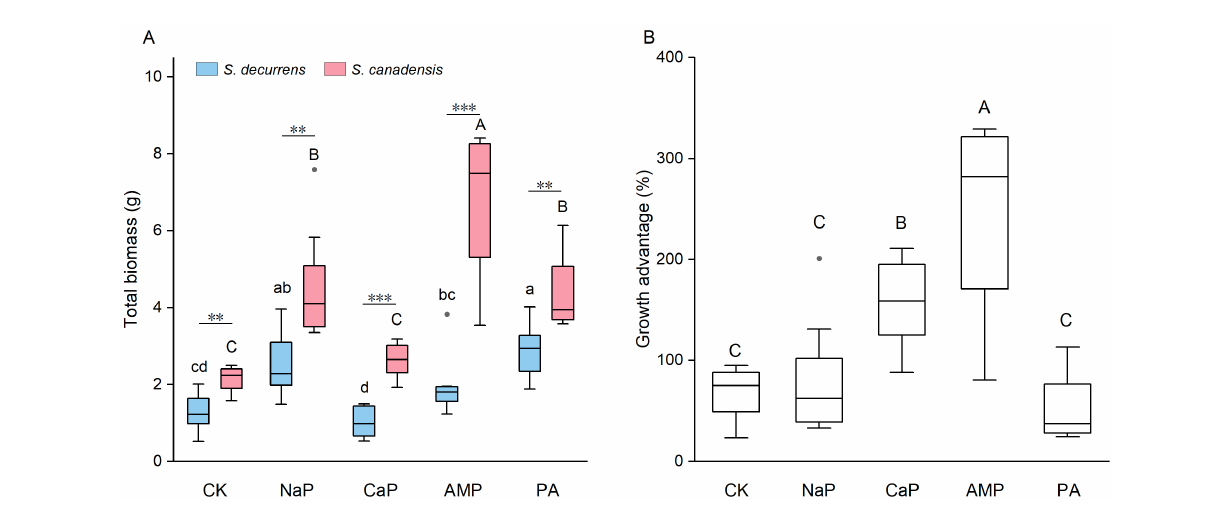
FIGURE 1 (A) Total biomass of S. decurrens and S. canadensis grown under five P treatments. CK: no P addition; NaP: sodium dihydrogen phosphate; CaP: hydroxyapatite; AMP: adenosine monophosphate; PA: myo-inositol hexakisphosphate. The line in the box represents the median value, box boundaries indicate the value in the 25–75th percentile range, whiskers indicate the 95% confidence intervals. The different lower-case letters among S. decurrens and different upper-case letters among S. canadensis denote significant differences at p < 0.05. The asterisks denote difference between S. decurrens and S. canadensis in the same P treatment. * p < 0.05, ** p < 0.01, *** p < 0.001. (B) The growth advantage of S. canadensis over S. decurrens under five P treatments. Different upper-case letters above the boxes indicate significant differences at p <